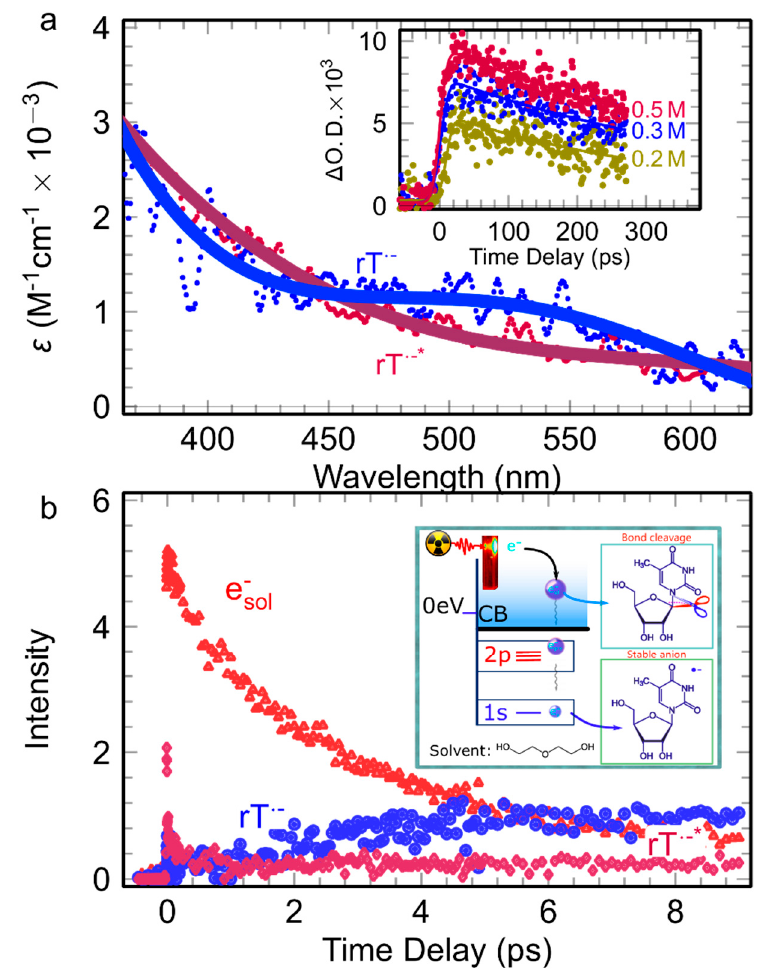
Figure 6. Observation of dissociative e qf- attachment to nucleoside via excited anion radical in solution. ( a ) Absorption spectra of the anion radical at ground (blue) and excited state (red). Inset: decay of the excited state observed at di ff erent concentration. ( b ) Kinetics of the di ff erent species showing the fast decay of rT • - * and the formation of rT • - by solvated electron. Inset: Scheme showing the reaction of quasi-free electron forming rT • - * in competition to the electron solvation process [75]. Reprinted with permission from [75]. Copyright 2019 Nature Springer.